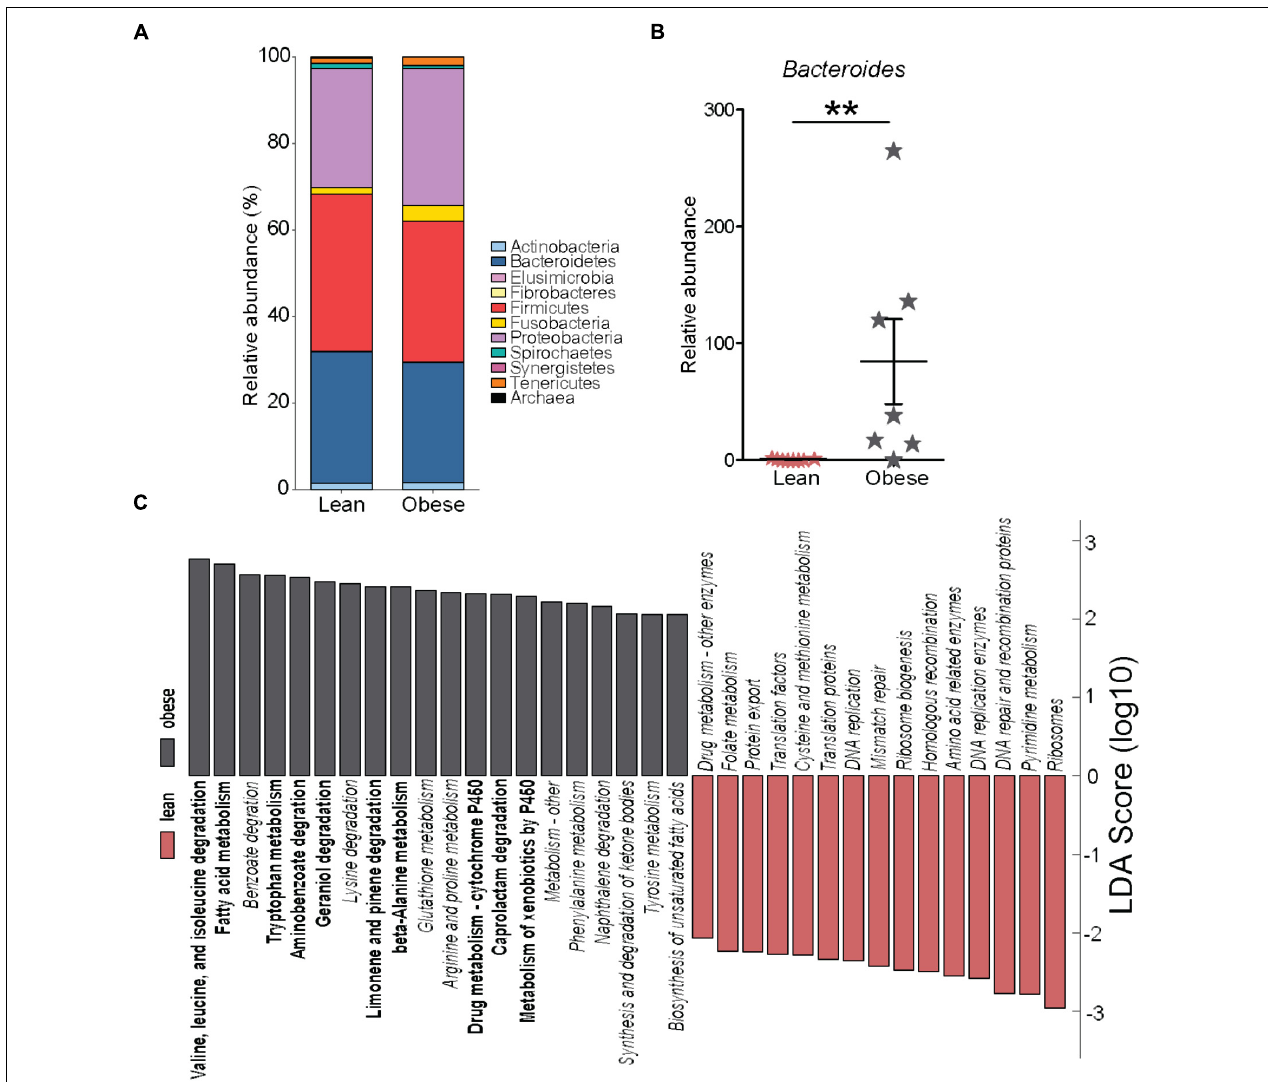
FIGURE 5 | Pregravid obesity is not associated with structural changes in its placental microbiome. (A) Median relative abundance of microbial communities at the phylum level reported by QIIME. No significant differences were observed. (B) Differences in the relative abundance of Bacteroides detected by both edgeR and Linear Discriminant Analysis (LDA) ( p < 0.01). (C) LDA of PICRUSt-predicted KEGG functions of microbial communities in the placentas from lean and obese subjects identified using LEfSe. Significant differences between groups are indicated as follows: ∗∗ p < 0.01.